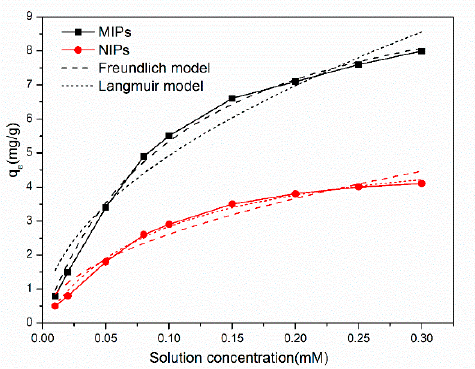
Figure 9. Adsorption isothermal fitting curves of MIPs and NIPs at 35 °C (10 mg of MIPs /NIPs in 5 mL SMZ solution with a concentration range of 0.02 to 0.3 mmol·L − 1 for 5 h).